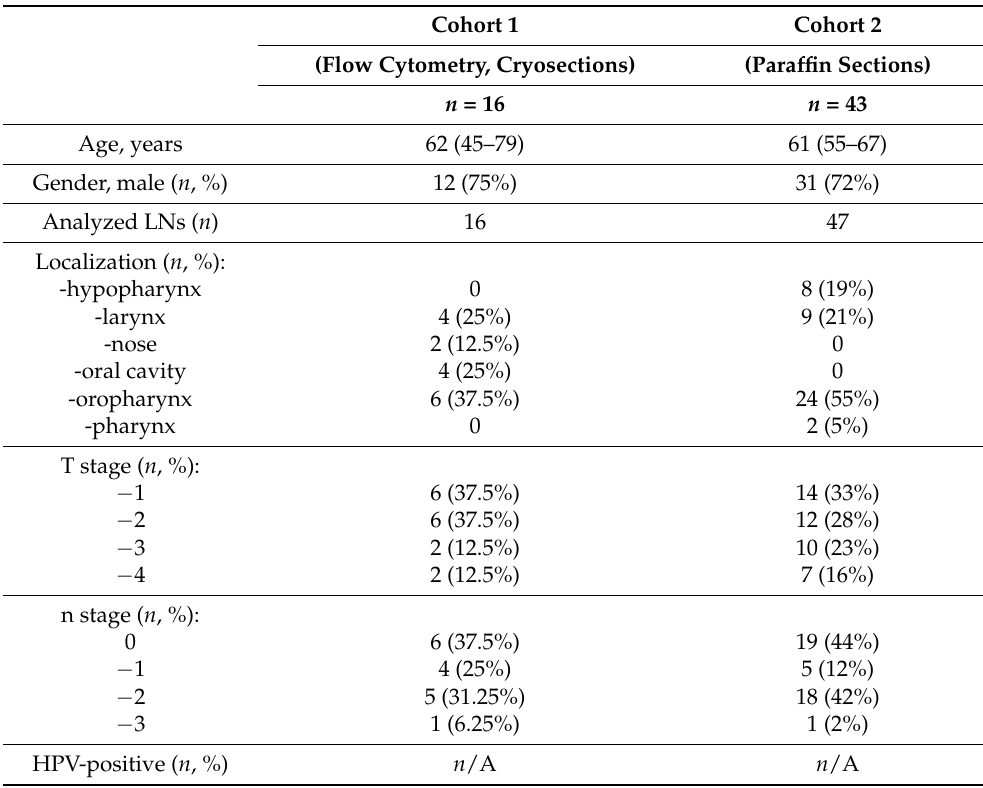
Table 1. Clinical characteristics of the patients